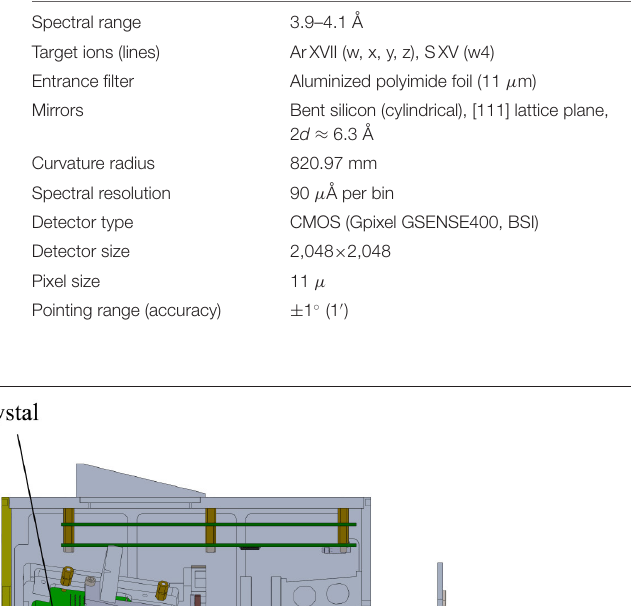
TABLE 7 | Main characteristics of Bragg X-ray spectrometer-polarimeter (B-POL).